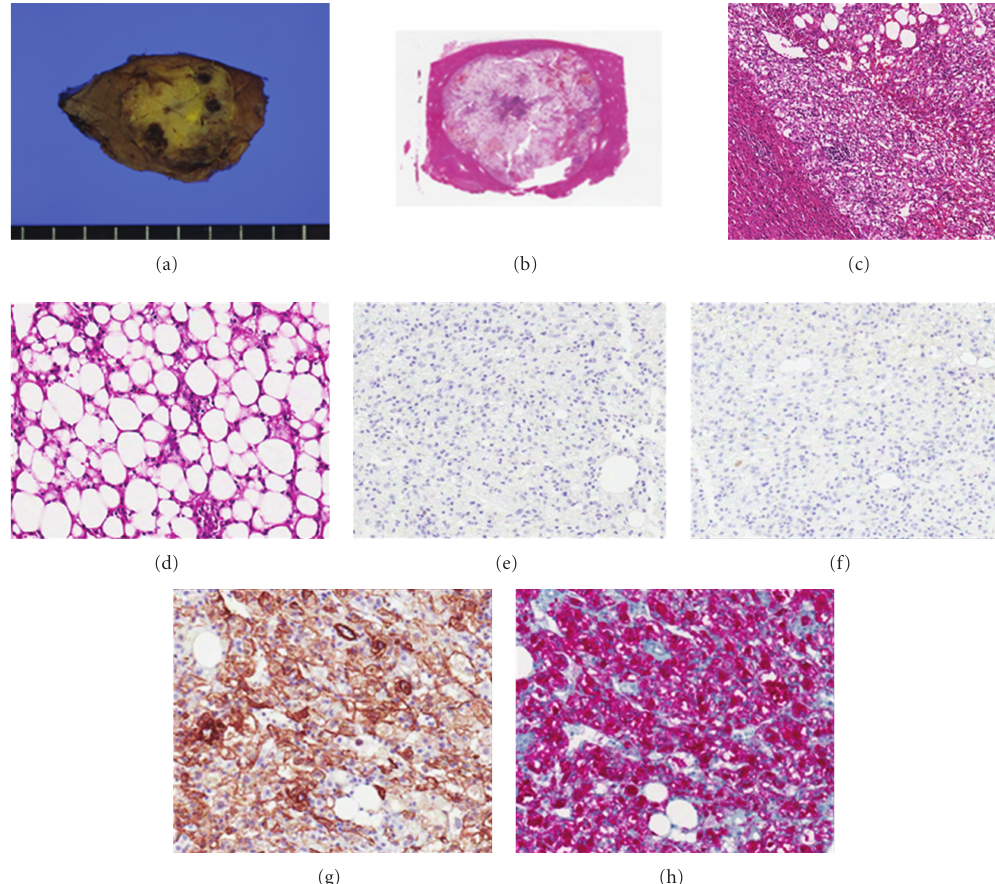
Figure 4: Pathologic findings of the liver mass ((a) Gross, (b)–(d); Hematoxylin & eosin stain, (e)-(f); Immnuohistochemistry ((e) anti- CK8/18, (f) anti-HSA, (g) anti-SMA, (h) anti-HMB45, (e)–(g) brown chromogen, (h) red chromogen), (b) × 1, (c) and (d) × 40, (e)–(h) × 200). The liver shows a well-demarcated mass with yellowish cut surface and hemorrhage. Microscopically, the mass composes of fat cells, vessels and epithelioid cells. The epithelioid cells exhibit non-epithelial origin (negative CK8/18 and negative HSA), SMA (+) and HMB45